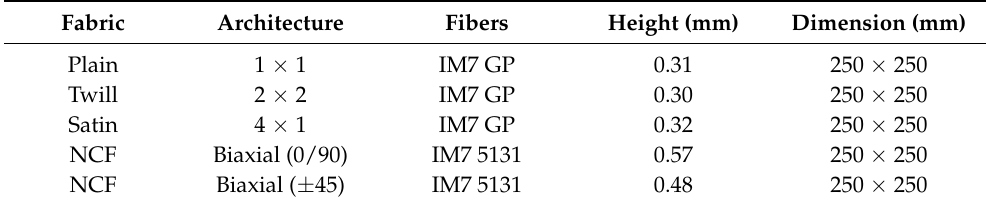
Figure 1. Reinforcements architectures: ( a ) Plain; ( b ) Twill; ( c ) Satin; ( d ) NCF 0/90; and ( e ) NCF ± 45. Table 1. Reinforcement characteristics for drapability